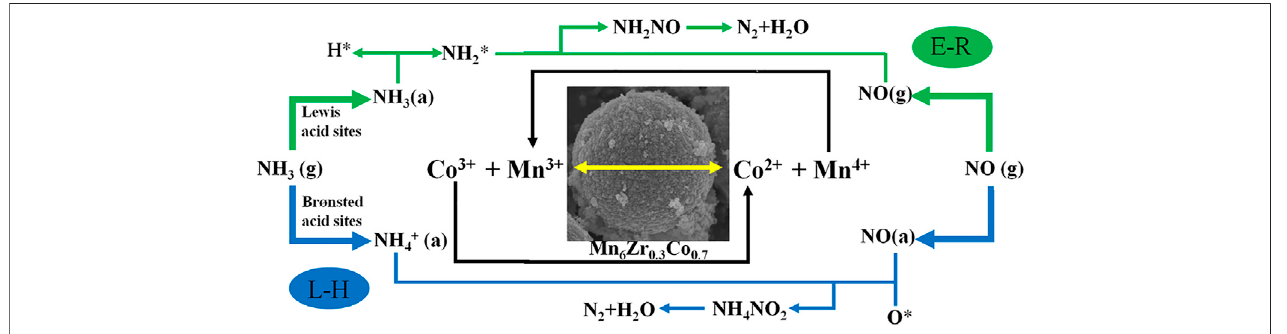
FIGURE 11 | Reaction mechanism of the Mn 6 Zr 0.3 Co 0.7